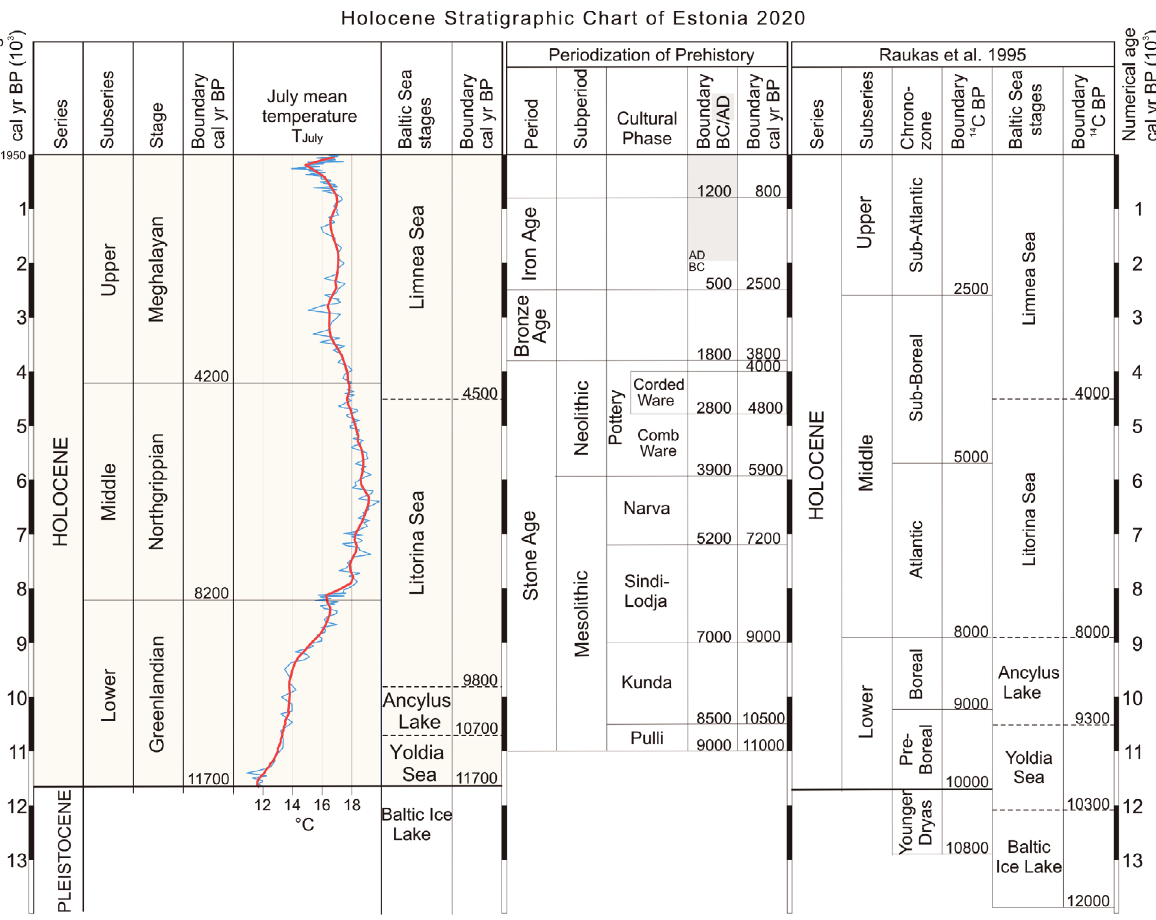
Fig. 1. The new Holocene Stratigraphic Chart of Estonia. The pollen­inferred July mean temperature curve (blue) and the smoothed curve (red) by LOESS with span 0.05 is a compilation from Lake Rõuge Tõugjärv and Lake Nakri records (Veski et al. 2004, 2015). The previous Holocene Stratigraphic Chart of Estonia after Raukas et al. (1995) with the uncalibrated 14 C age scale is